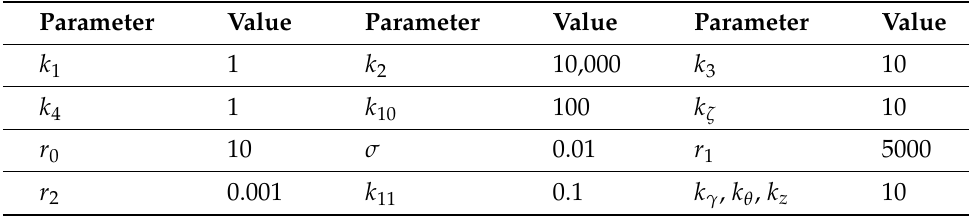
Table 2. Parameters of the proposed controller and the compared controller.